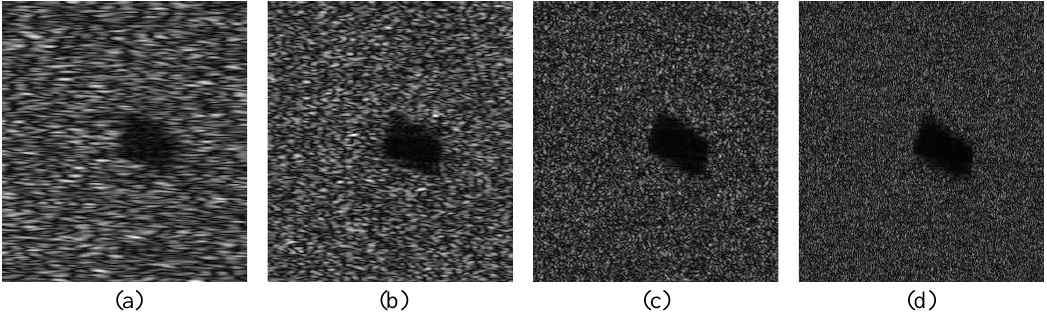
Figure 10. Effect of aperture on shadow (horizontal is azimuth; vertical is range), ( a ) 100 m, ( b ) 200 m ( c ) 500 m, ( d ) 1000